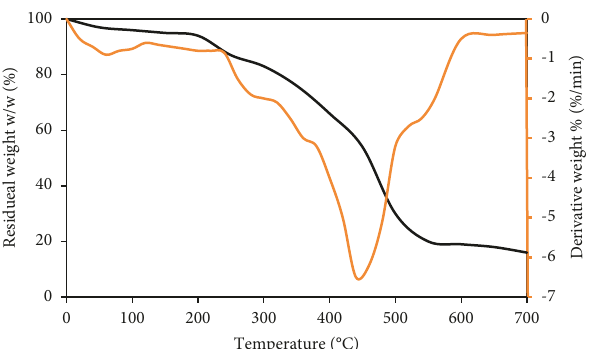
Figure 1: TG and DTG curve of the biomass material.